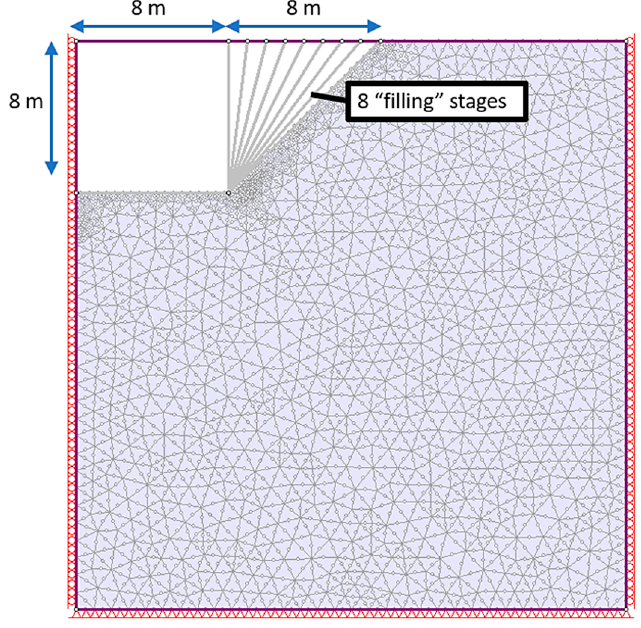
Figure 6. Inclined slope problem geometry.